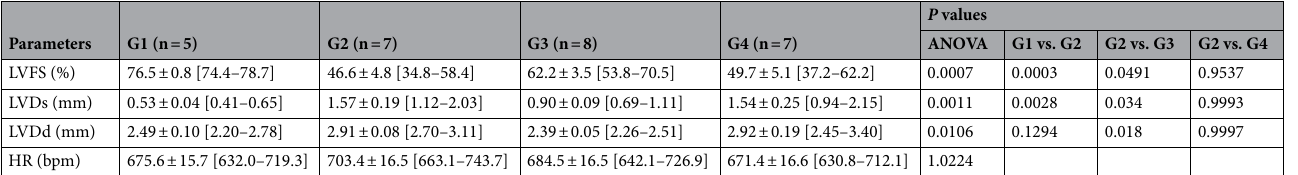
Table 2. Echocardiographic data on day 21 in experimental autoimmune myocarditis (EAM) mice. Data are mean ± SEM [95% confidence interval]. Echocardiographic findings on day 21 in non-EAM mice daily treated with vehicle only (G1: n = 5) or in EAM mice daily treated with vehicle (G2: n = 7), selective prostaglandin E2 receptor 4 (EP4) agonist (ONO-0260164) (G3: n = 8), or both ONO-0260164 and selective EP4 antagonist (CJ- 42794) (n = 7) from day 14 to day 21. P values were calculated with 2-way ANOVA followed by the Bonferroni- Dunn post hoc testing method. LVFS left ventricular fractional shortening, LVDs LV end-systolic dimension, LVDd LV end-diastolic dimension, HR heart